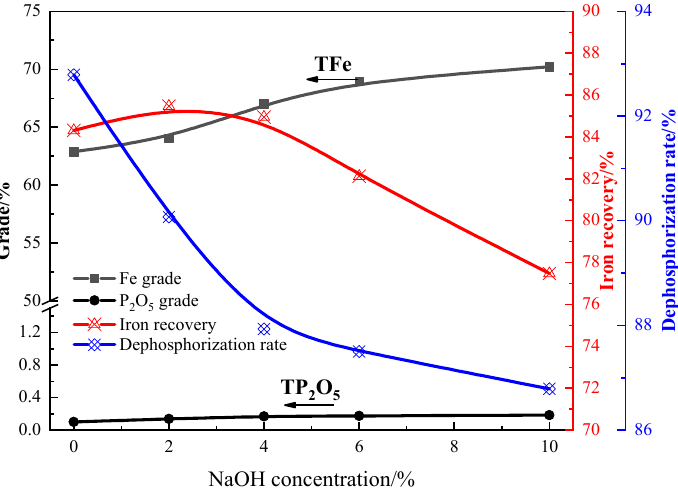
Figure 8. Effect of NaOH concentration on the indices of iron ore concentrate. Table 3. Reaction of Δ GT–T relationship in the system with the addition of NaOH.